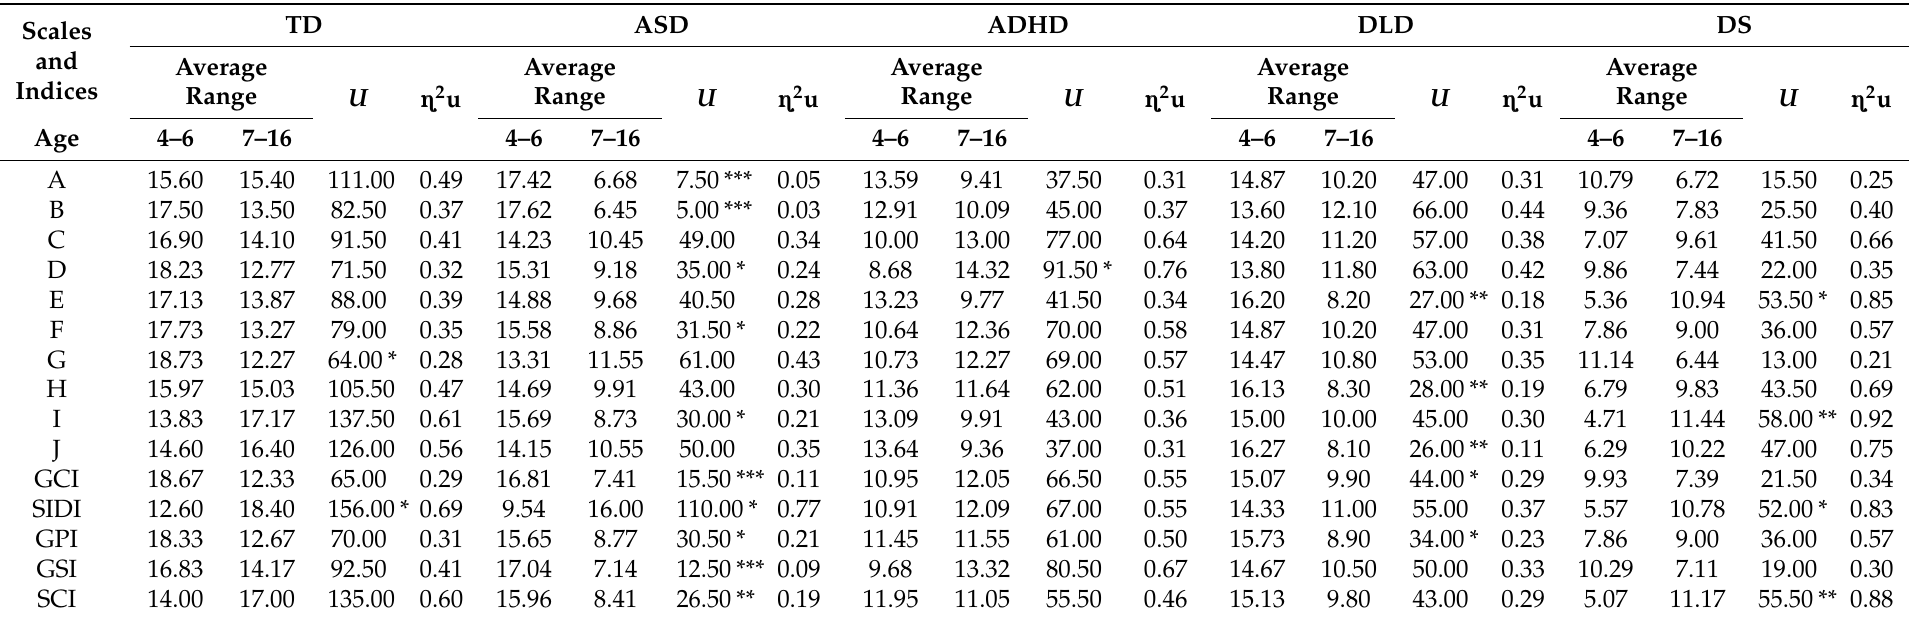
Table 7. Comparison between the scores obtained by preschool and school age children in each of the groups using the Mann–Whitney U statistic.